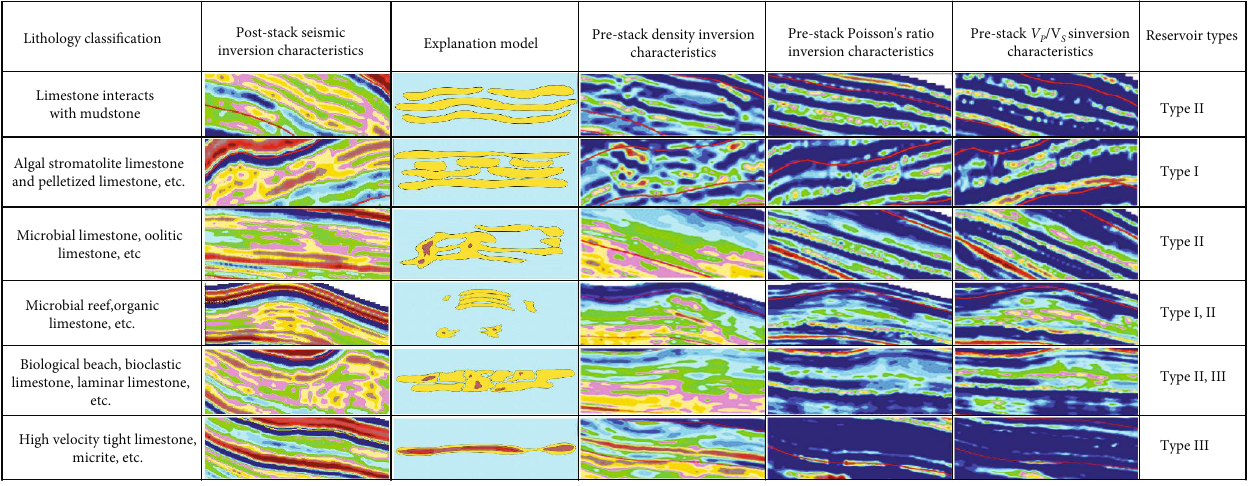
Figure 15: Prediction models of the di ff erent lithologies and lithological